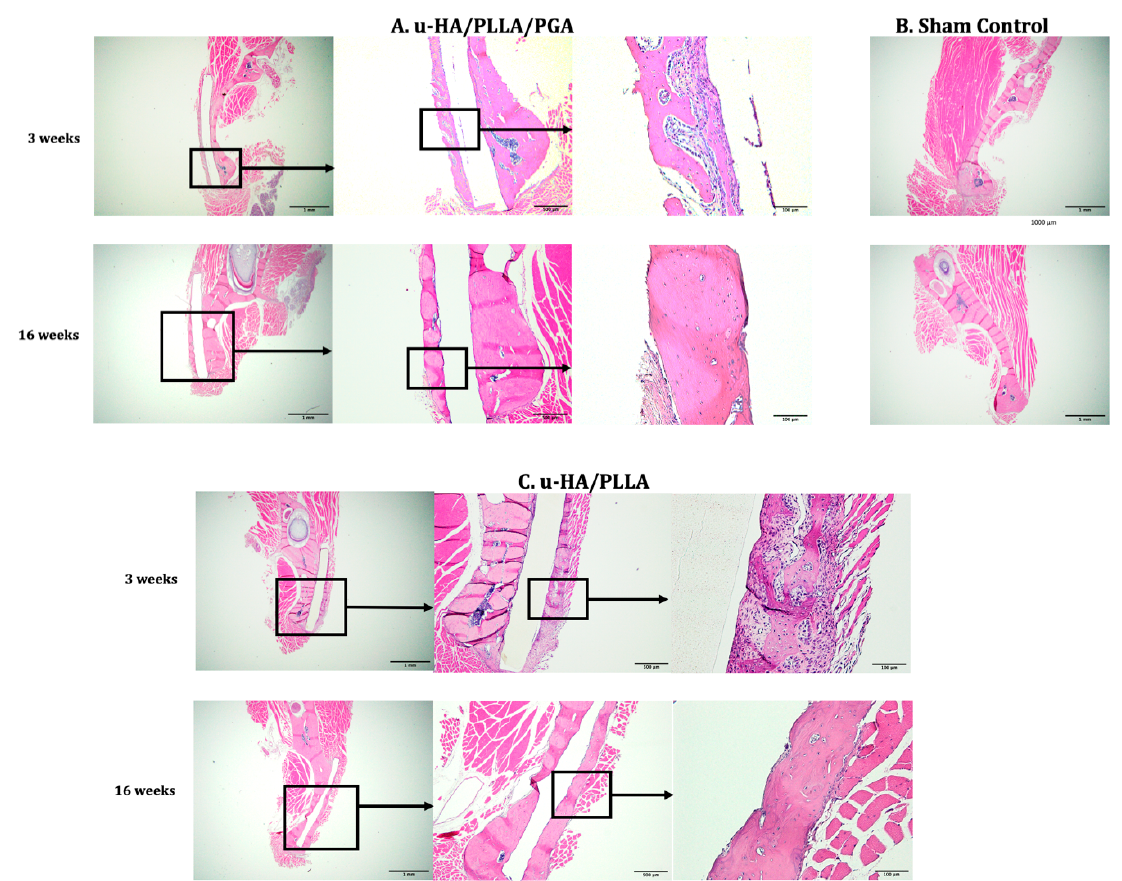
Figure 7. Hematoxylin-and-eosin-stained sections from the u-HA/PLLA/PGA subgroup, u-HA/PLLA subgroup, and sham control. Images of each subgroup were taken at 1.25×, 4×, and 20× magnification (from left to right). Images of the sham control group were taken at 1.25× magnification. ( A ) u-HA/PLLA/PGA subgroup. ( B ) Sham control group. ( C ) u-HA/PLLA subgroup. Scale bar: 1 mm (1.25× magnification), 500 μ m (4× magnification), and 100 μ m (20× magnification).